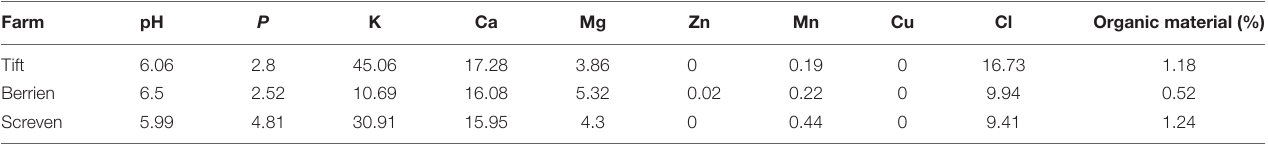
Farm pH P K Ca Mg Zn Cu Cl Organic material